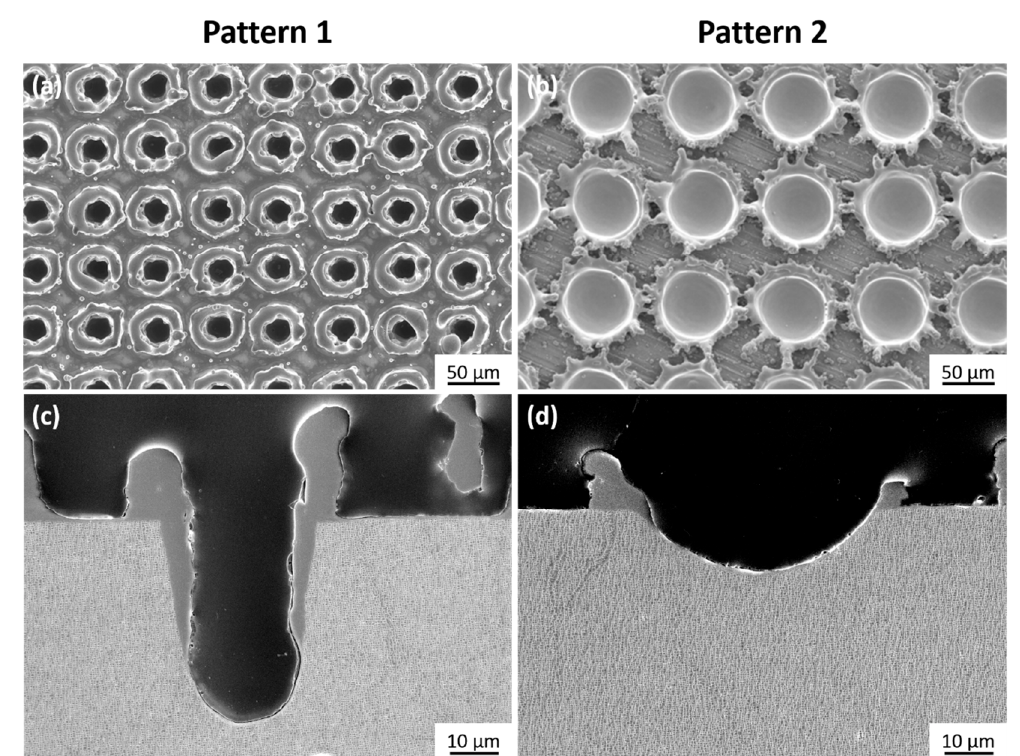
Figure 2. ( a ) Top view of pattern 1, ( b ) top view of pattern 2, ( c ) cross ‐ section of pattern 1, ( d ) cross ‐ section of pattern 2.